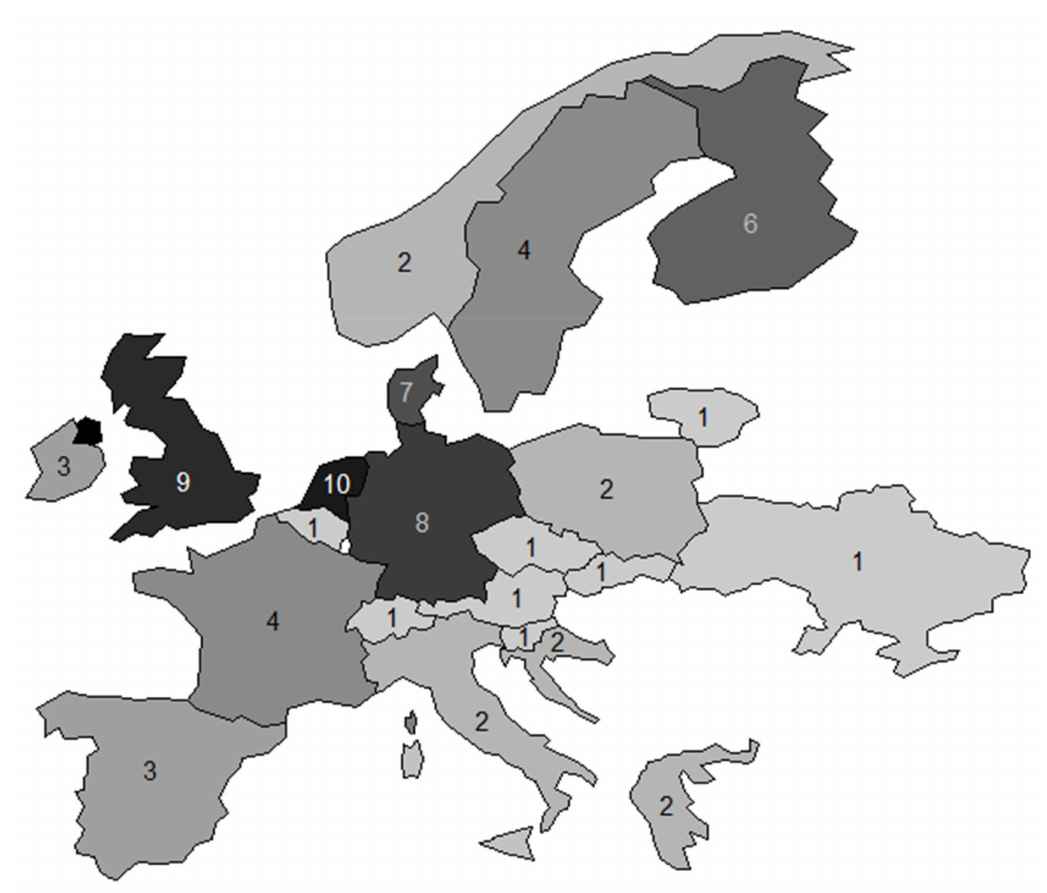
Figure 2. Distribution of pregnancy cohorts by country. Each country is represented using a grey-scale according to the number of pregnancy cohorts. The number of pregnancy cohort is also